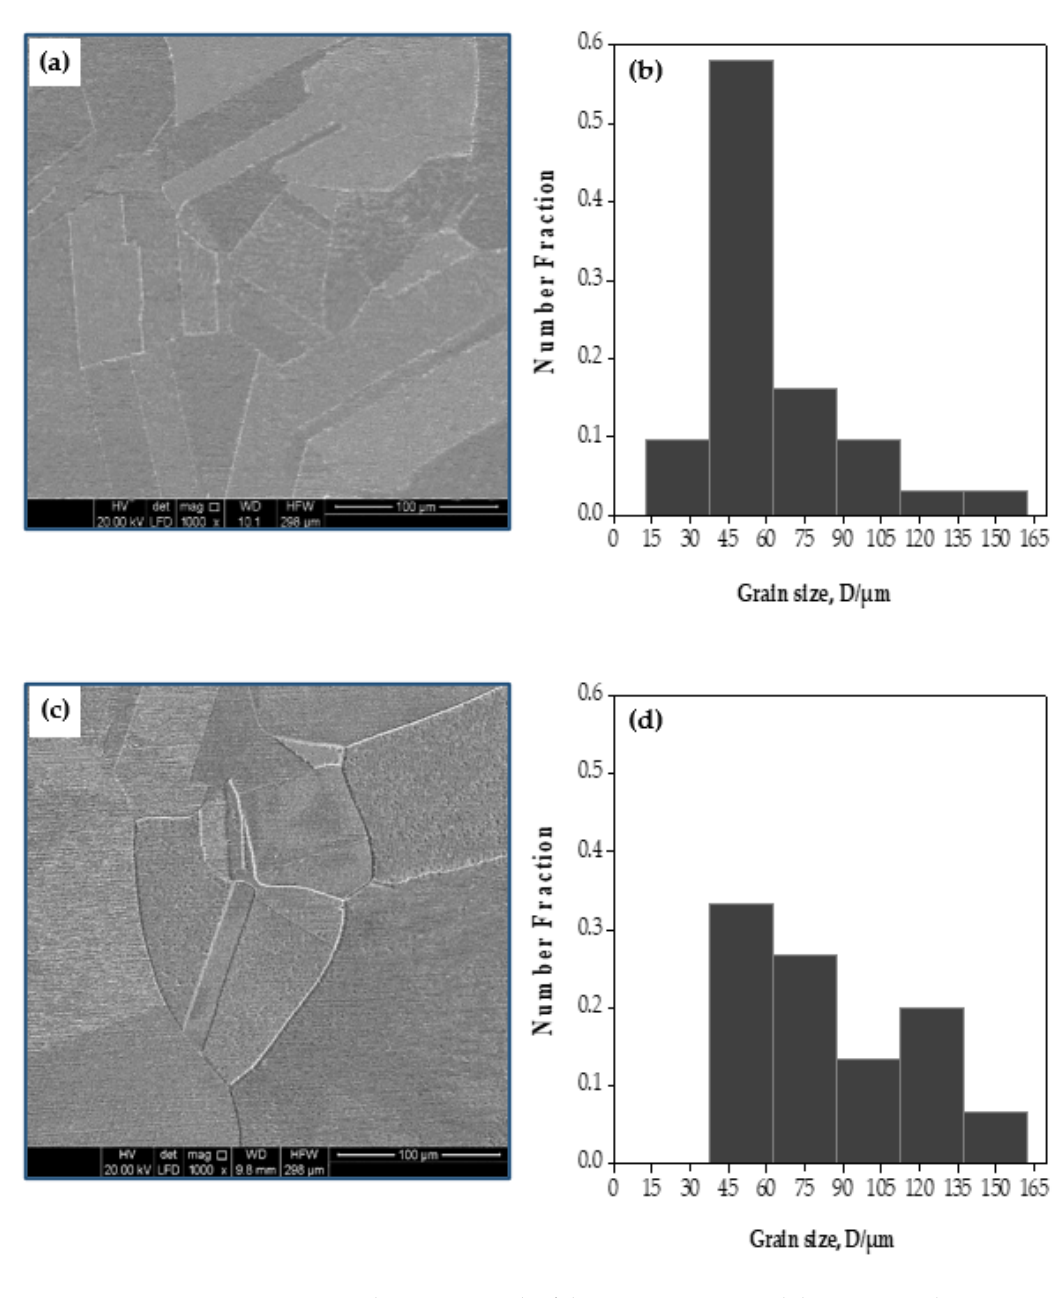
Figure 3. SEM photomicrograph of the microstructure and the corresponding grain size distribution of annealed ( a , b ) copper and ( c , d ) brass tubes.